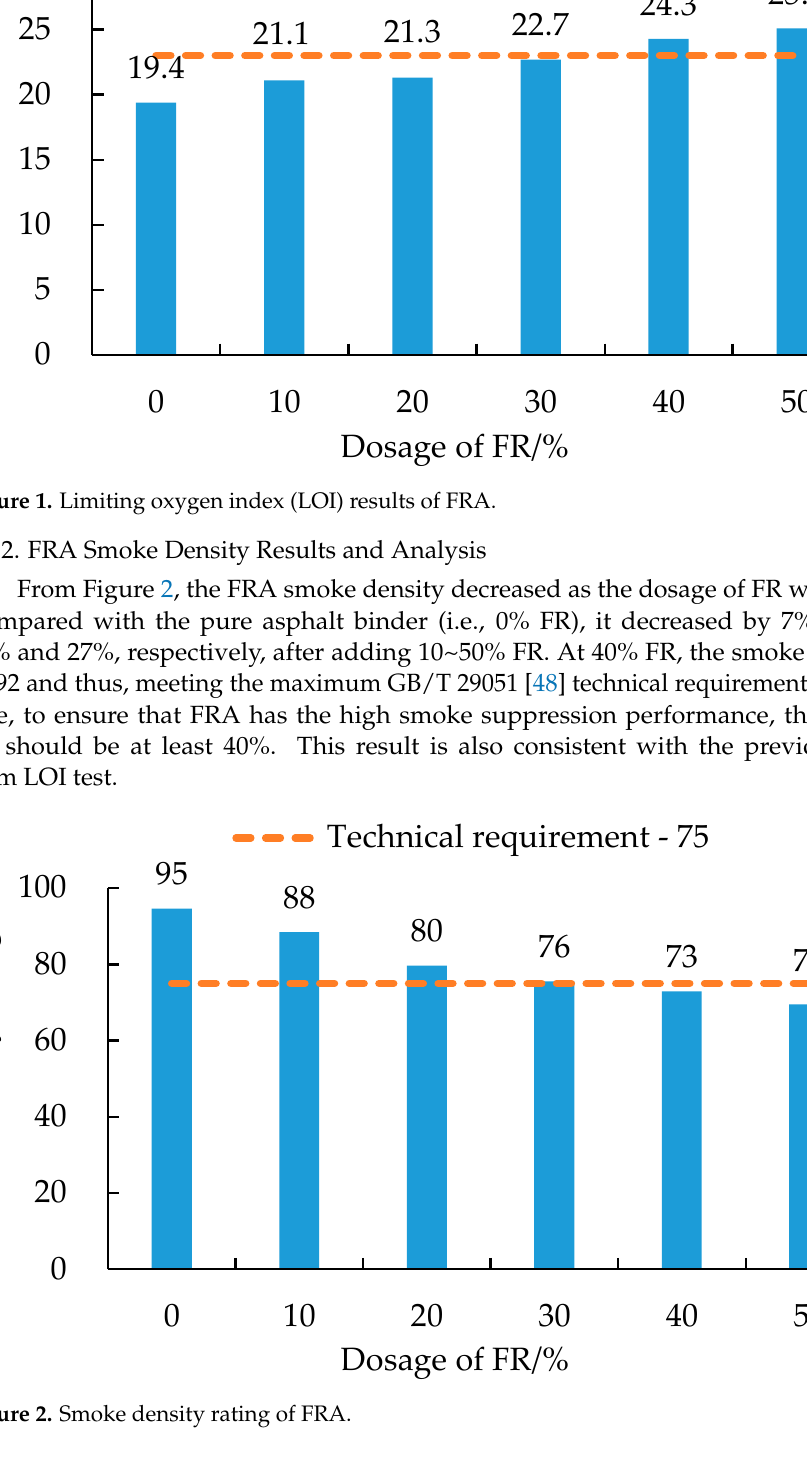
( b ) Figure 3. Thermal analysis curves of pure FR: ( a ) TG-DTG curve; ( b ) TG-DSC curve. 3.2.2. Thermal Degradation Characteristics of FRA As can be seen from Figure 4, the TG-DSC curves of FRA containing various contents of FR had smaller weight loss rate and lower heat flow peak than that of the pure asphalt binder. This indicated that the addition of FR effectively inhibited the thermal degradation